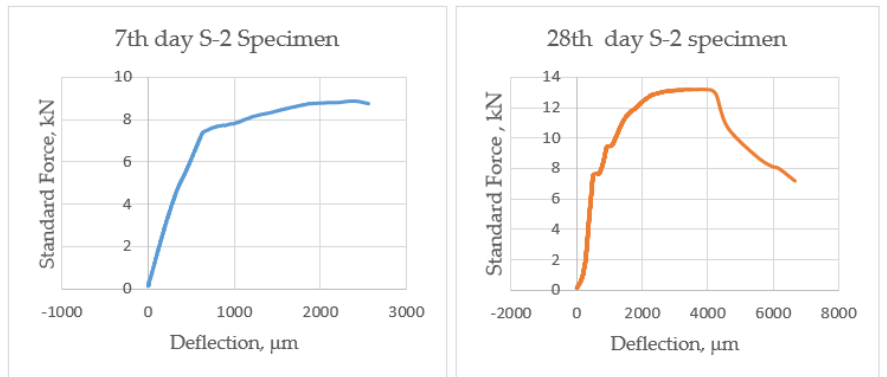
Figure 9. Crack behavior of sample S-2 after 7 and 28 days of hardening.